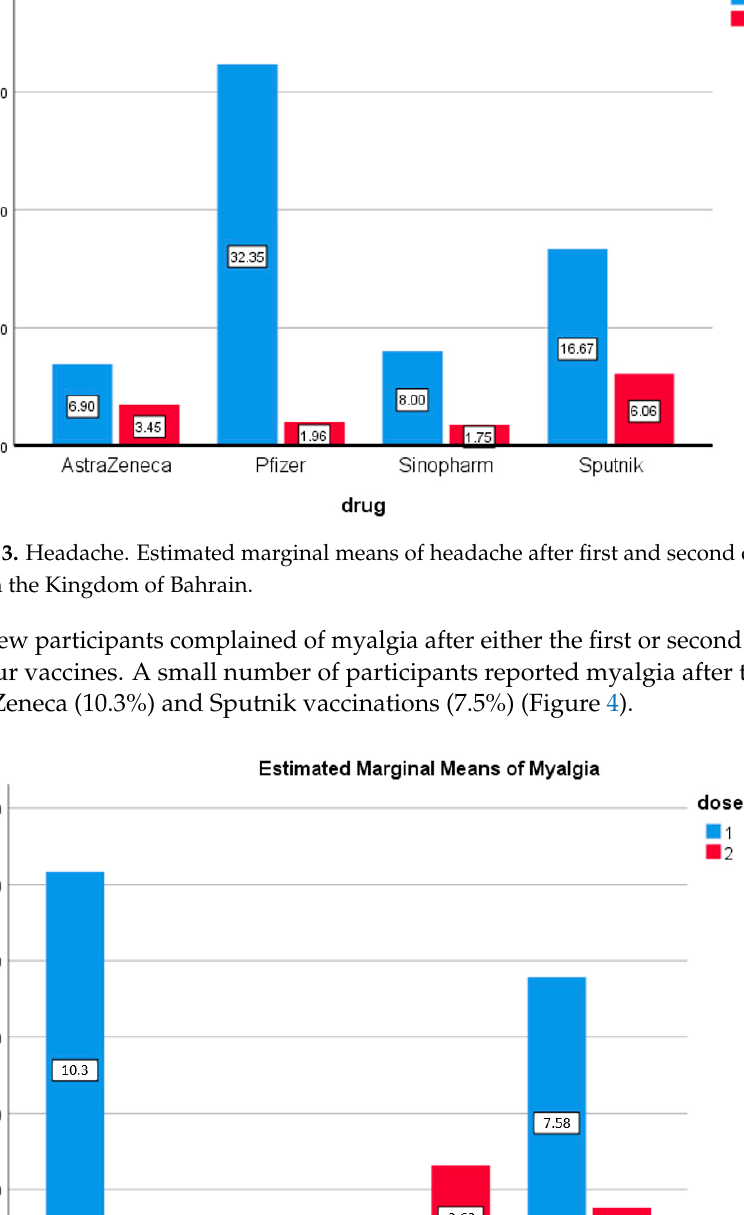
Figure 5. Nausea. Estimated marginal means of nausea after first and second doses of vaccines used in the Kingdom of Bahrain.